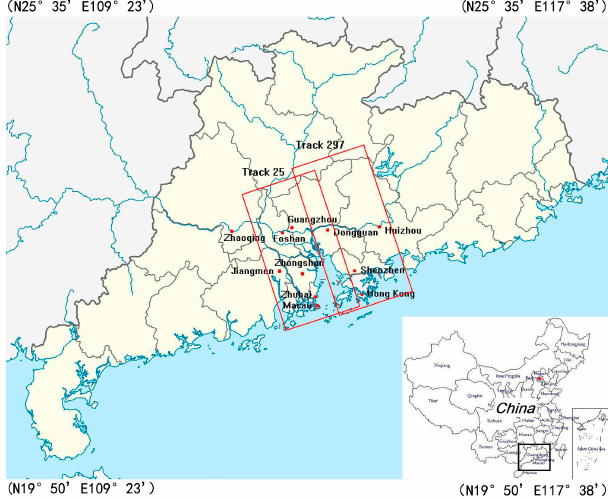
Fig. 1. Location of the Greater Pearl River Delta (GPRD) re- gion, comprising Hong Kong, Macao and the nine municipalities of Guangdong Province. Two ascending tracks of Envisat ASAR data (Tracks 25 and 297), marked by red rectangles, are analyzed for surface settlement inversion covering the whole GPRD region except for Zhaoqing